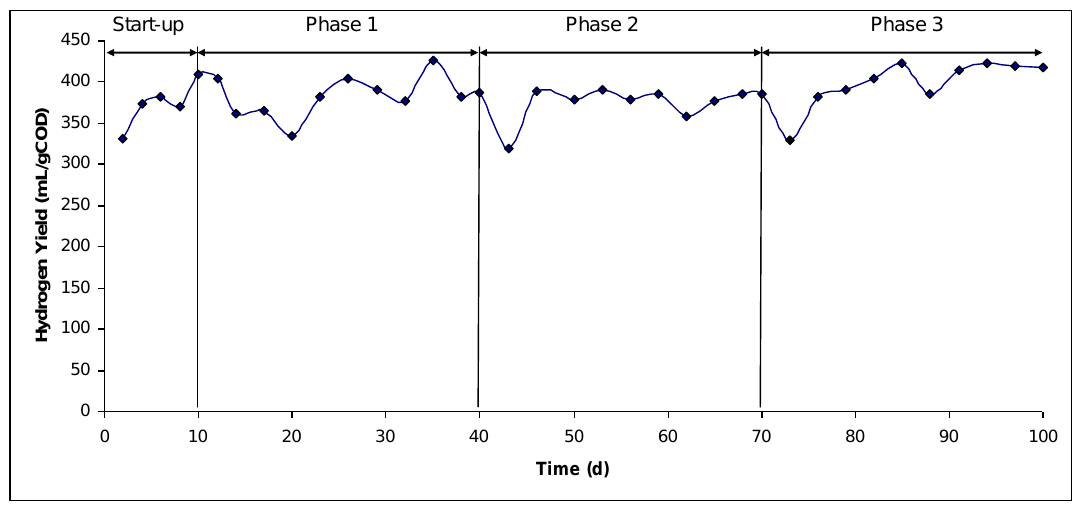
Figure 4. Volumetric hydrogen yield